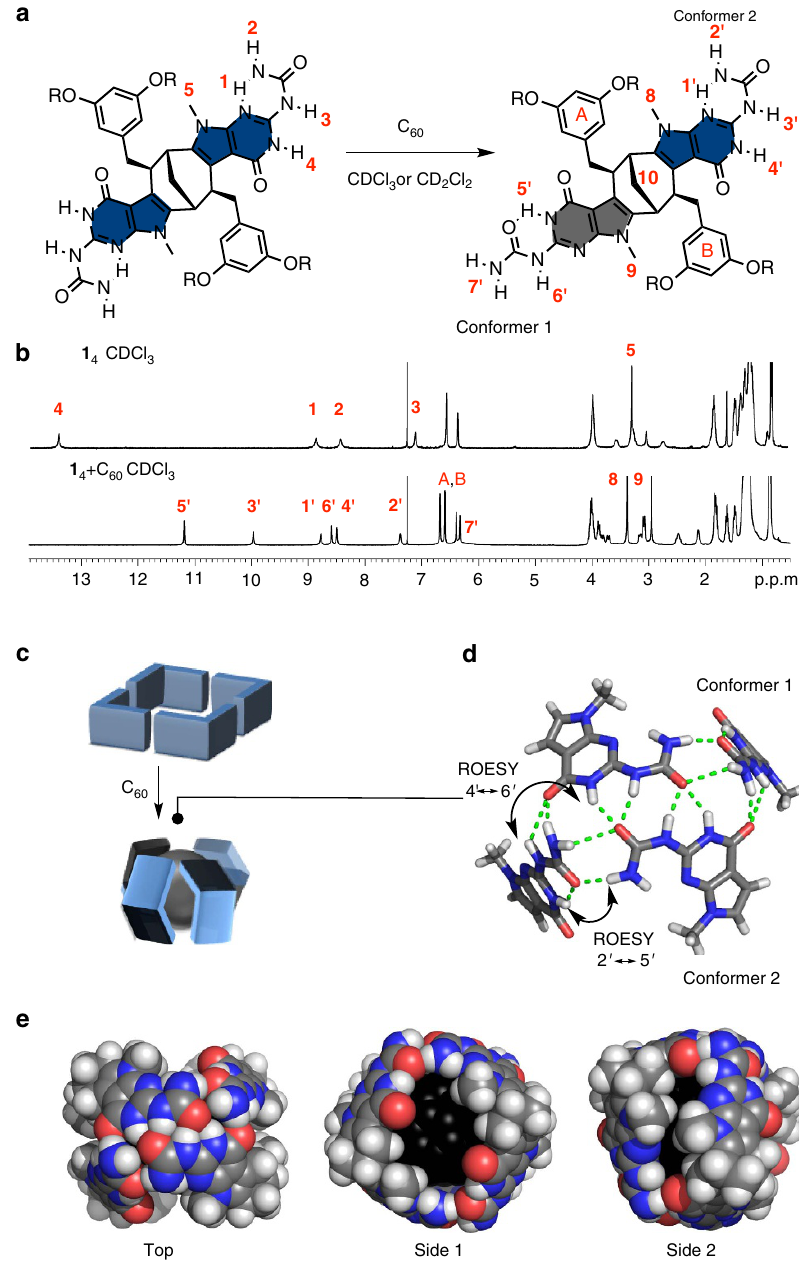
Figure 4 | Structure of the insertion complex C 60 @1 4 . ( a ) Symmetry breaking of monomer 1 by conformer redistribution in PUPy units. Conformer 1 (grey) and conformer 2 have the same 6[ 1H ]-pyrimidinone tautomeric form but different intramolecular H-bonds. ( b ) 1 H NMR spectrum of 1 4 (top) and C 60 @ 1 4 (bottom). ( c ) Schematic representation of starting tetramer 1 4 and capsular complex C 60 @ 1 4 . ( d ) Top view of H-bonding interface between two conformers of PUPy with rotating-frame nuclear Overhauser effect interactions indicated. H-bonds are presented by dashed green lines. ( e ) Top and side views of the optimized molecular models of C 60 @ 1 4 . Carbons in C 60 molecule are labelled is in accord with its much weaker out-of-plane intermolecular chains (Fig. 4e, Side 2). The other control compound 4 did not H-bonding with the carbonyl group of the urea moiety as interact with C 60 either, because the corresponding capsule opposed to nearly optimal H-bonding in the free tetramer 1 4 cannot form without H-bond donors on the terminal urea group (Fig. 4b,d). The 4:1 ( 1 :C 60 ) stoichiometry of the complex was (Fig. 4d). According to molecular modelling (Supplementary determined from molar-ratio method using 1 H NMR Fig. 62), the capsule embraces the C 60 guest ( d ¼ 0.71 nm) so (Supplementary Fig. 61) and is also in line with an even number tightly that having the same diameter but being only slightly of monomers required for their symmetric alternating arrange- ment within the aggregate. Moreover, the control compound 3 with bulkier decyl groups on the pyrrole ring was not able to form was first formed with an open form of the 1 4 tetramer, which the corresponding capsule-like insertion complex due to very ultimately led to polymers (C 70 @ 1 4 ) n via rim-to-rim aggregation unfavourable intermolecular steric interactions between decyl